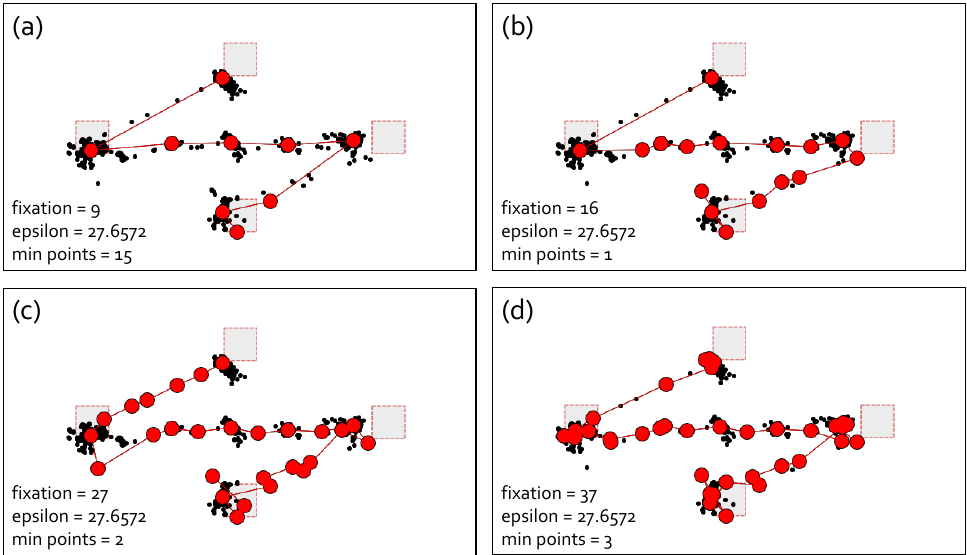
Figure 5. DBSCAN with IQR fixation identification. ( a – d ) The different cases of fixation identi- fications. The minPoint parameter in each case is presented in each image. The epsilon (eps) is automatically set based on Q3, the third quartile (75%), from the center of gaze distributions [6]. Similar to Figure 3, the black dots denote the raw gaze points, and the red dots indicate the fixations. The red links are the